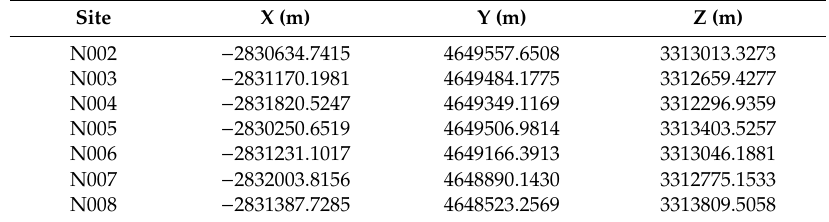
Figure 4. The absolute value of differences between SD and 3D approach derived parameter estimation after outlier elimination. The values of parameter 12 and 13 are zero due to floating-point number round-off. Table 4. Final sites’ coordinate parameters estimation after elimination of outliers determined by SD or 3D method.